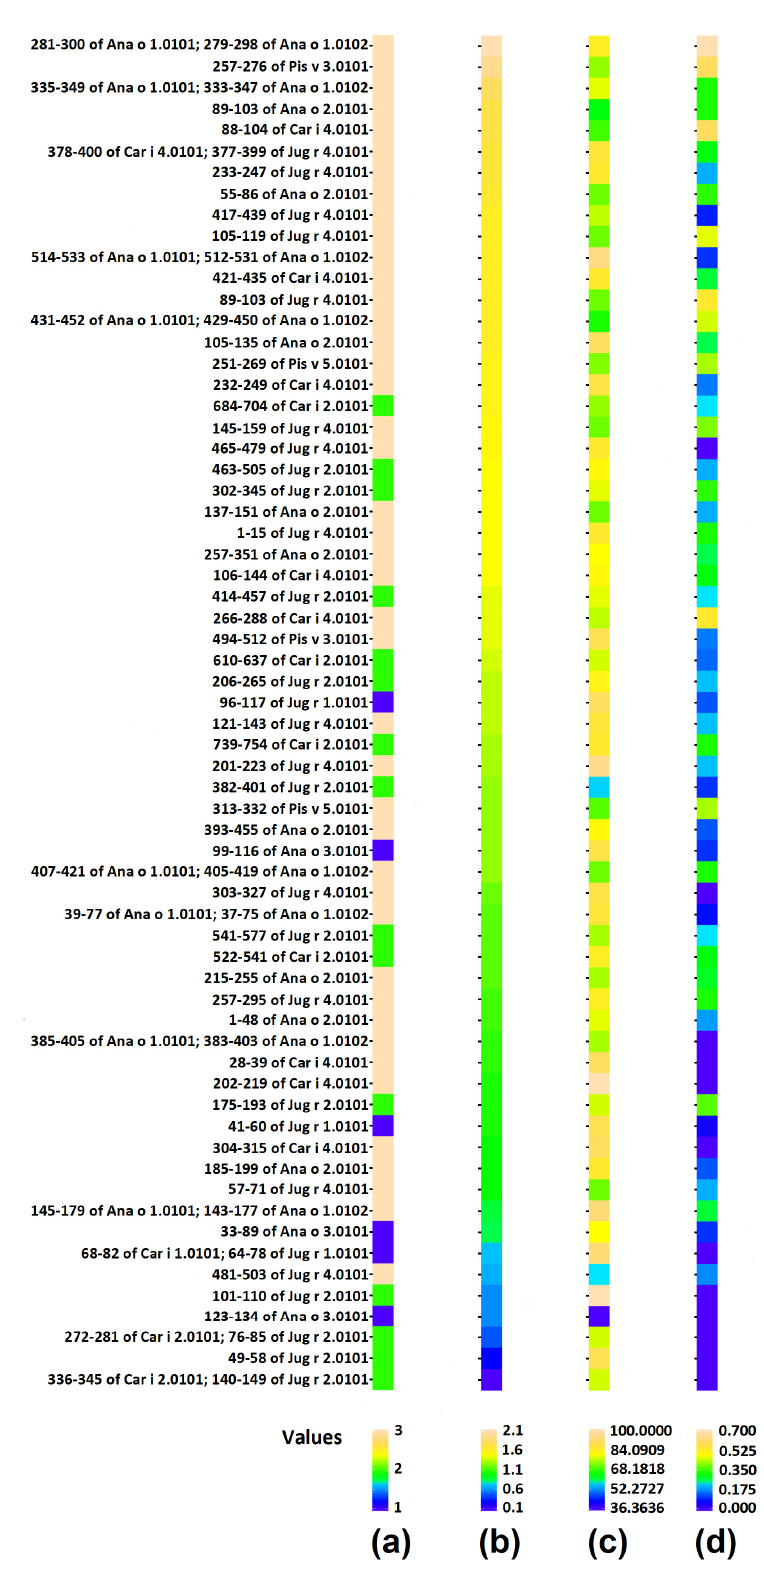
Figure 6. Scores concerning potential release of bioactive peptides from epitopes. ( a ) domain sets present in proteins: 1 (blue)—Set 1; 2 (green)—set 2; 3 (yellow)—set 3 (3a + 3b); ( b ) ∑ A; ( c ) DH t [%]; ( d ) ∑ A E . Epitopes are sorted from highest to lowest ∑ A value (column ( b )).